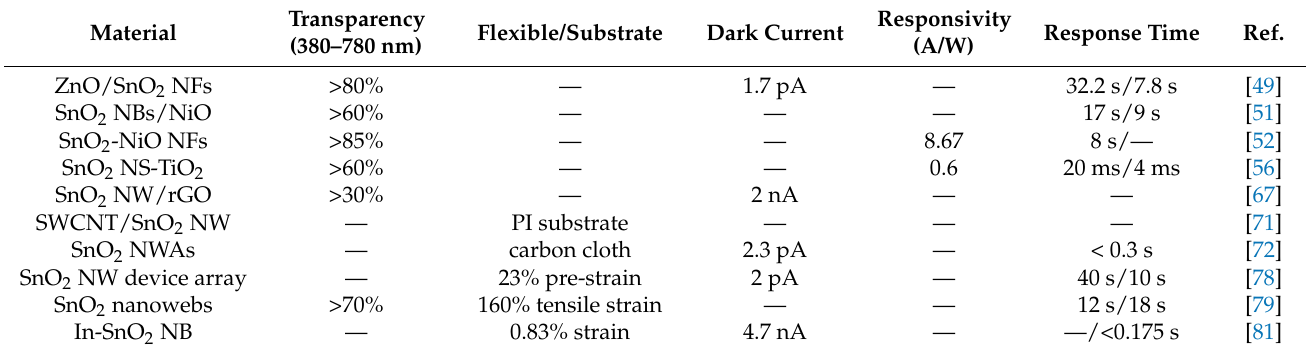
Table 2 summarizes the research progress of transparent and flexible SnO 2 UV pho- todetectors. Table 2. Comparison of the parameters of various